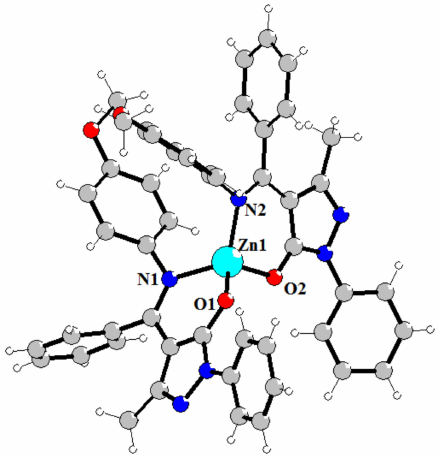
Figure 1. Structure of complex 4. Selected bond’s length (Å): Zn1-O2 1.9542(16), Zn1-O1 1.9437(16), Zn1-N2 1.9788(19), Zn1-N1 2.0089(19), Zn2-O6 1.9501(16), Zn2-O5 1.9584(16), Zn2-N7 2.0049(19), Zn2-N8 1.9887(19).